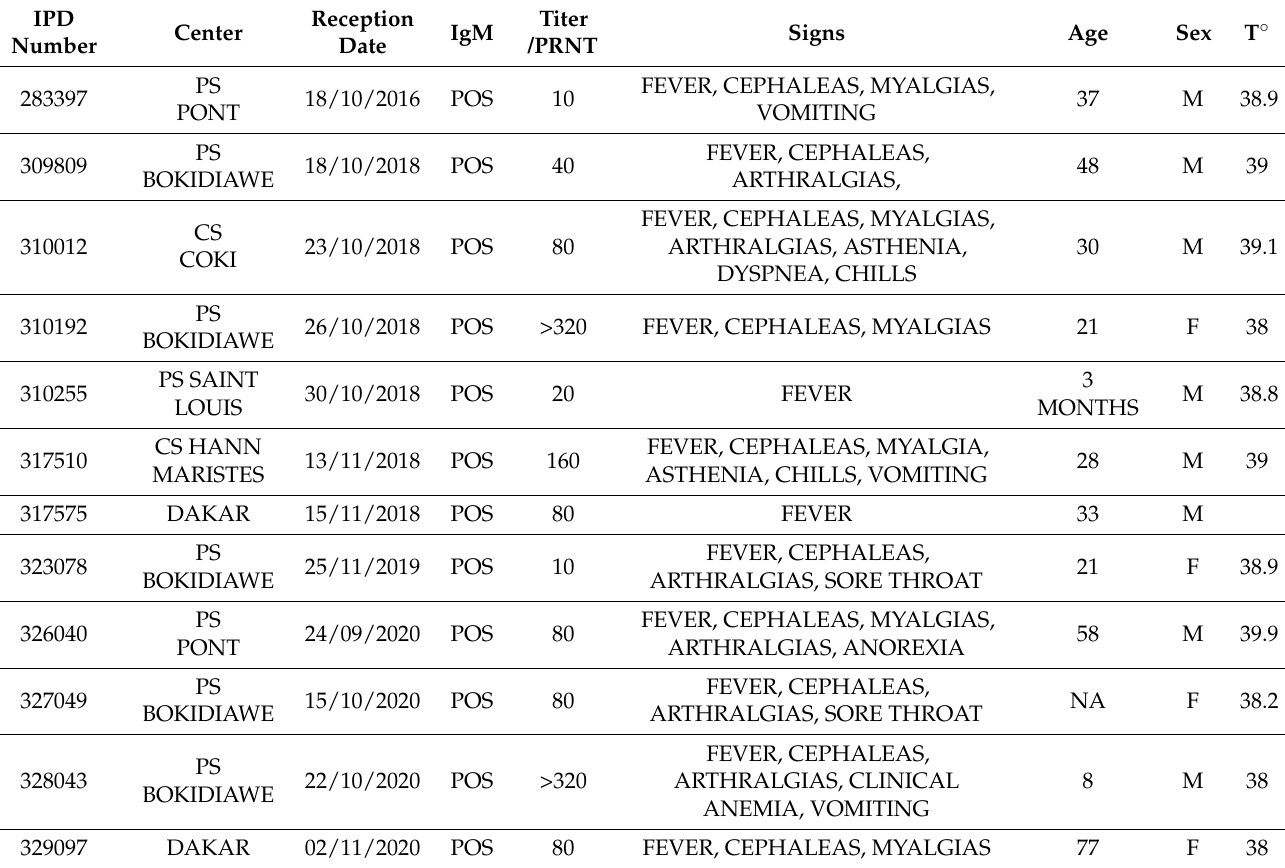
Table 2. This table shows informations about the clinical data (developed clinical signs, age, sex, temperature) of the WNV-positive patients in Senegal 2016–2021, their residence, the date of collection of their serums, and the results of serological tests carried out (ELISA and